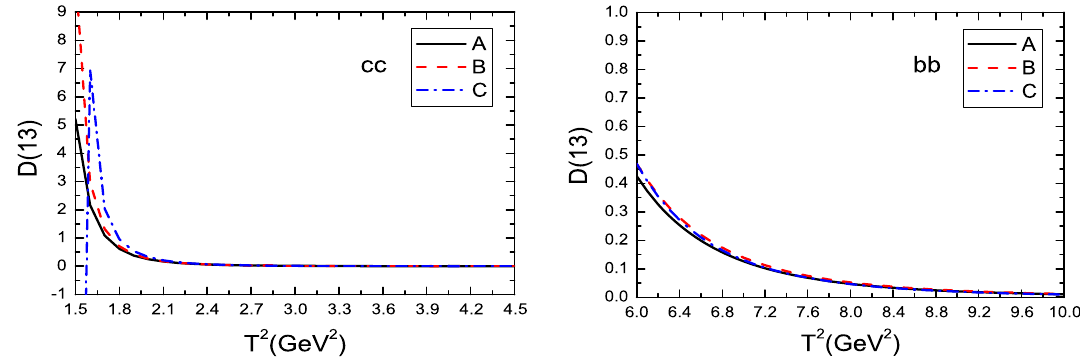
Fig. 3 The contributions of the vacuum condensates of dimension 13 in the operator product expansion, where A , B and C denote the doubly heavy pentaquark states with J = 1